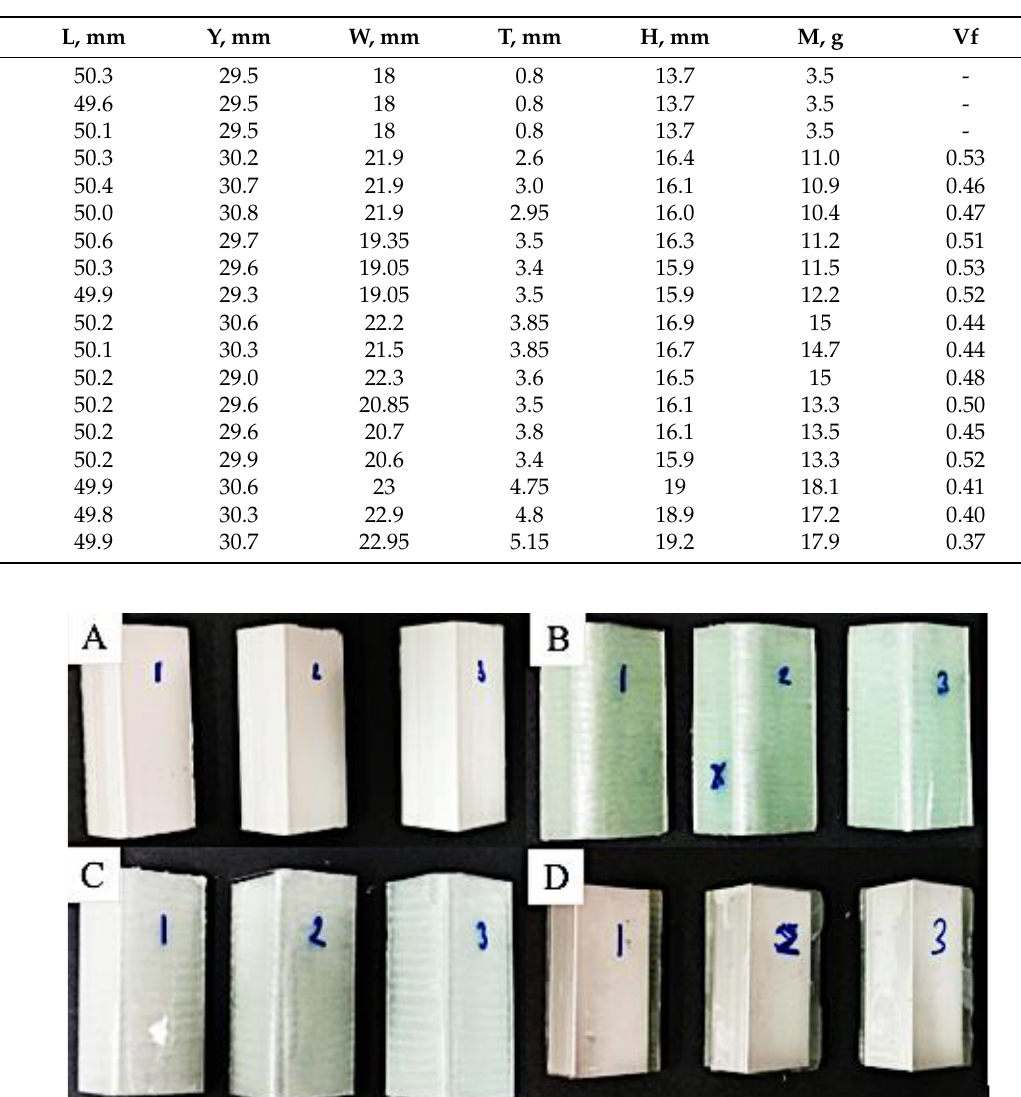
Table 2. Lateral compression specimen dimensions and volume fraction.